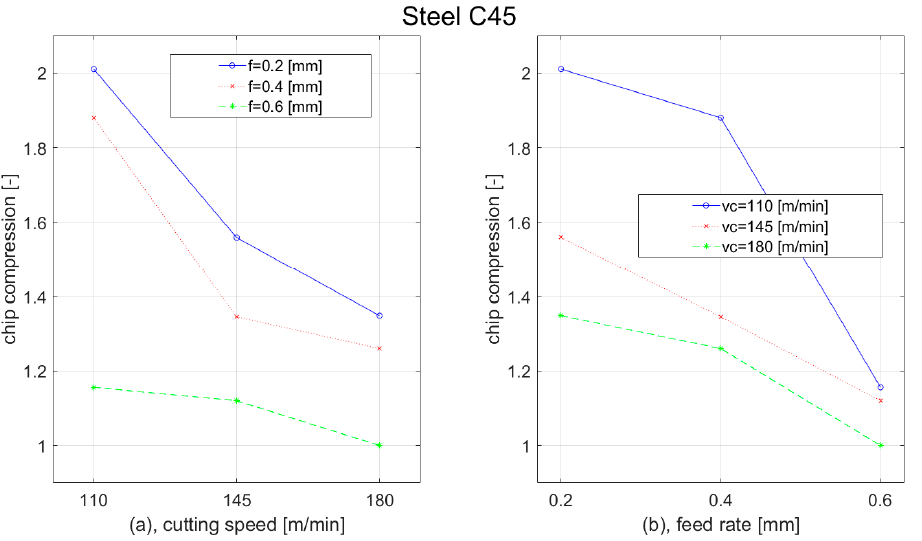
Figure 12. Graph of chip compression dependence of Steel C45 on: ( a ) cutting speed; ( b ) feed rate.